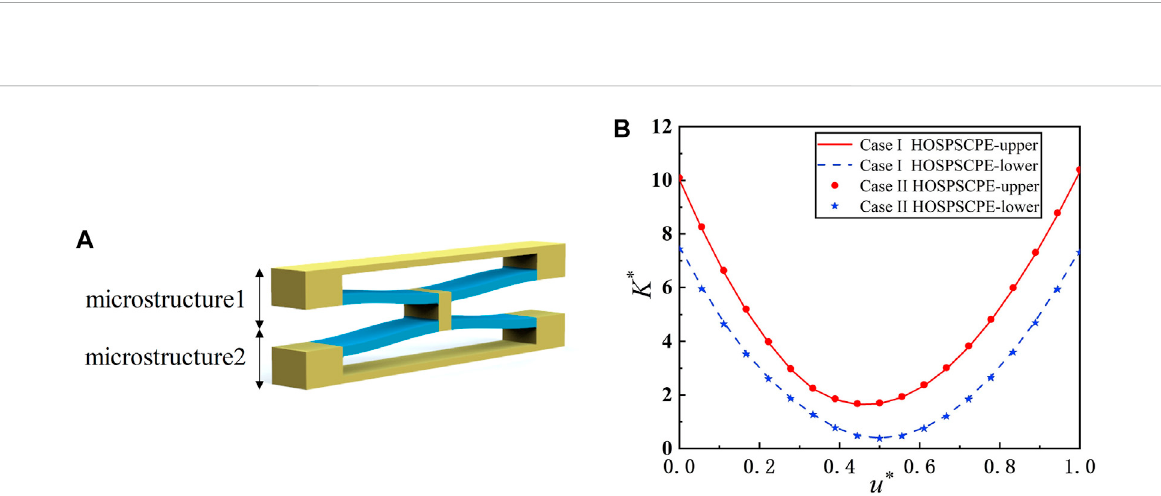
normalized displacement; K * = K / K 0 , the normalized stiffness with K 0 being the lowest stiffness. It can be found in the fi gure